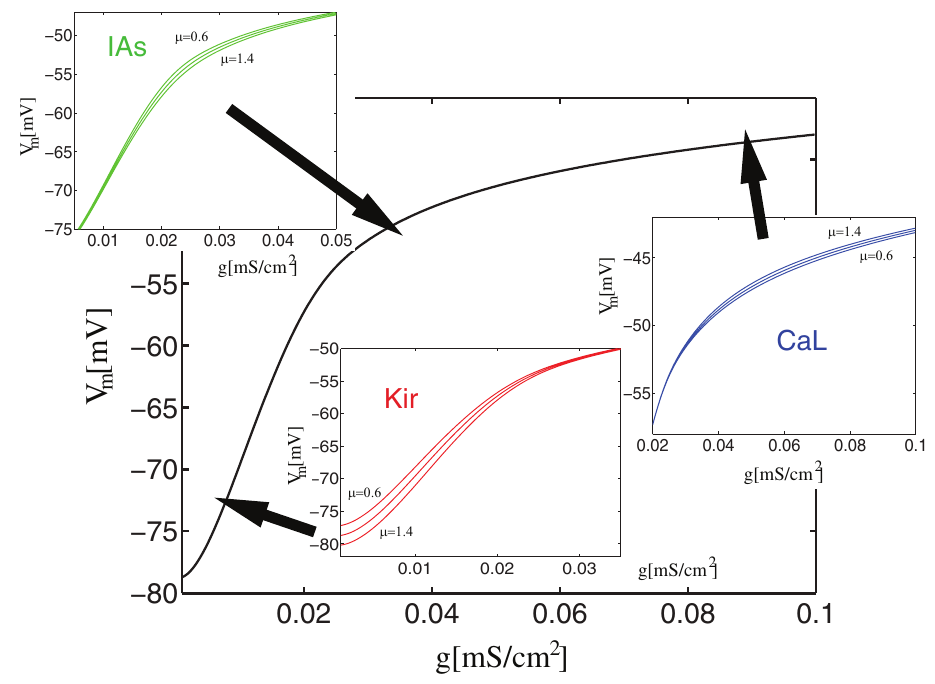
Figure 2. Modulation of the activation function. Variable factors ( µ = {0.6 ... 1.4}) for I As , I CaL , and I Kir as components of the activation function ( g s vs. V m ). This function is defined as the membrane voltage response for different injected (synaptic) conductances ( g s ), and computed by solving Eq 3 for the membrane voltage V m .